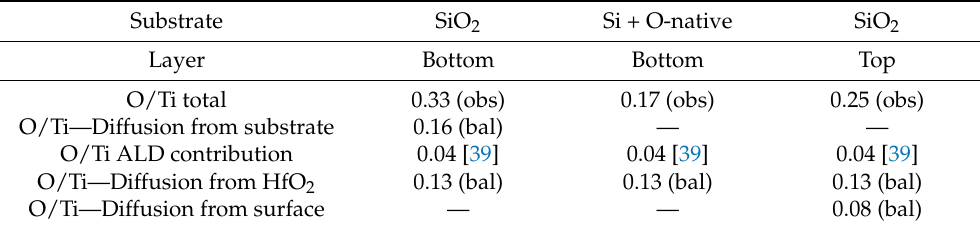
Table 1. Relative atomic % content O/Ti in TiN x